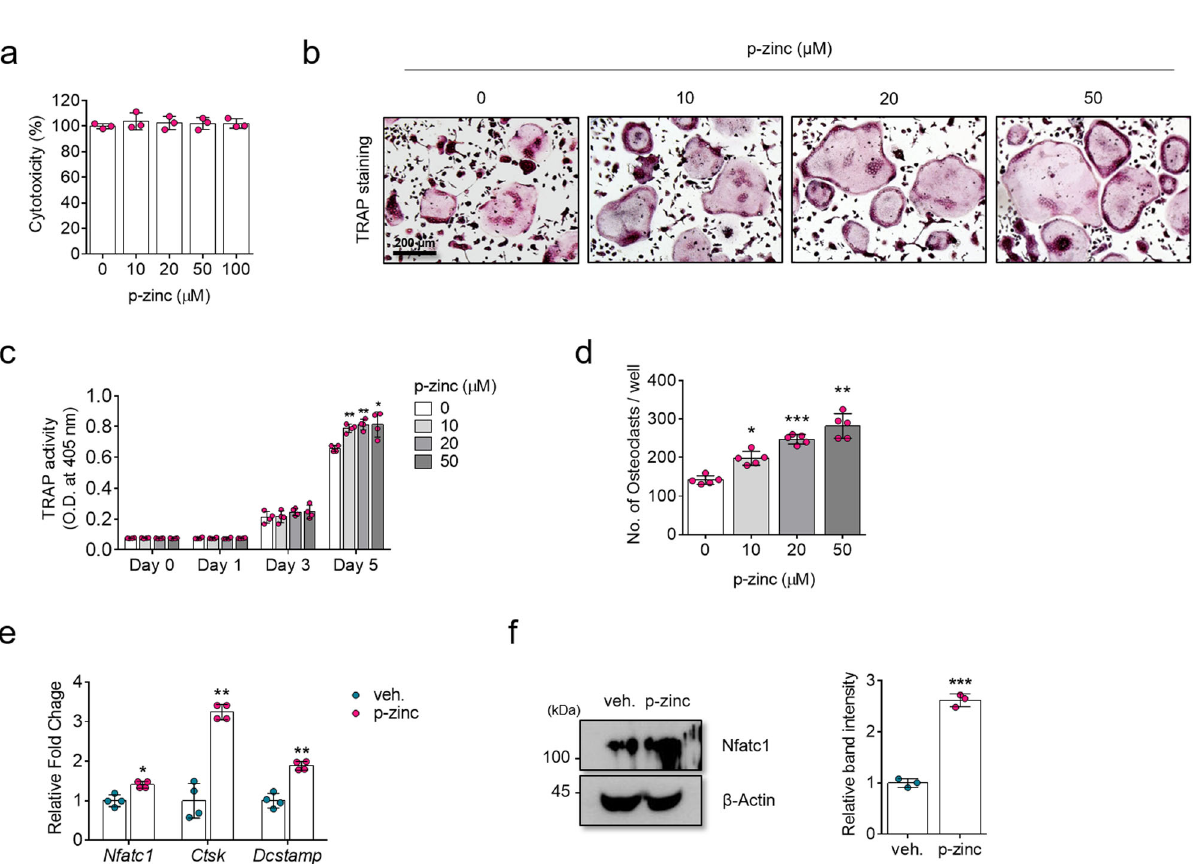
Fig. 2 Effects of polaprezinc on the osteoclast differentiation of mBMMs. a The Ez-Cytox assay was used to determine the cellular toxicity of polaprezinc-treated mBMMs at 5 days. Each experiment was performed in triplicate ( n = 3). There was no signi fi cant difference between groups. b Representative images of osteoclast differentiation. mBMMs treated with different concentration of polaprezinc were seeded in 12-well culture plates and treated for 5 days with 10 ng/mL M-CSF and 10 ng/mL RANKL. TRAP staining was performed to visualize TRAP-positive mBMMs. Scale bar = 200 μ m. c TRAP activity was determined as described in the materials and methods section. The absorbance was measured at 405 nm and data are expressed as the mean ± S.D. ( n = 3) from each independent experiment. * P < 0.05 and ** P < 0.01 compared with vehicle-treated mBMMs. d The number of TRAP- positive multinucleated osteoclasts (5 ≥ nuclei) was counted. * P < 0.05; ** P < 0.01; *** P < 0.001 compared with vehicle-treated BMMs. e Graphs were generated from real-time quantitative PCR data using RNA extracted from mBMMs treated with polaprezinc (50 μ M) under osteoclastogenic conditions for 3 days. The results were compared to those of the group treated with vehicle ( n = 3 experimental replicates). f The protein level for NFATc1 was analyzed in mBMMs using western blotting for cells treated with vehicle or polaprezinc (50 μ M) under osteoclastogenic conditions for 3 days. The band intensity was quanti fi ed using ImageJ software ( n = 3, in triplicate) and each Nfatc1 protein level was normalized to the β -Actin protein level. *** P < 0.001 compared with vehicle-treated